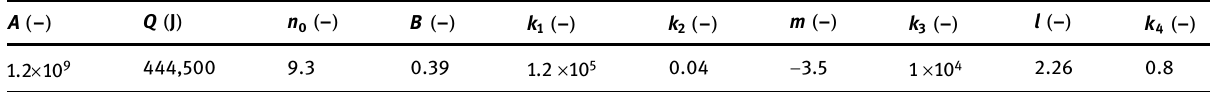
Table 3: Fitted parameters in the stress relaxation model ( ) A